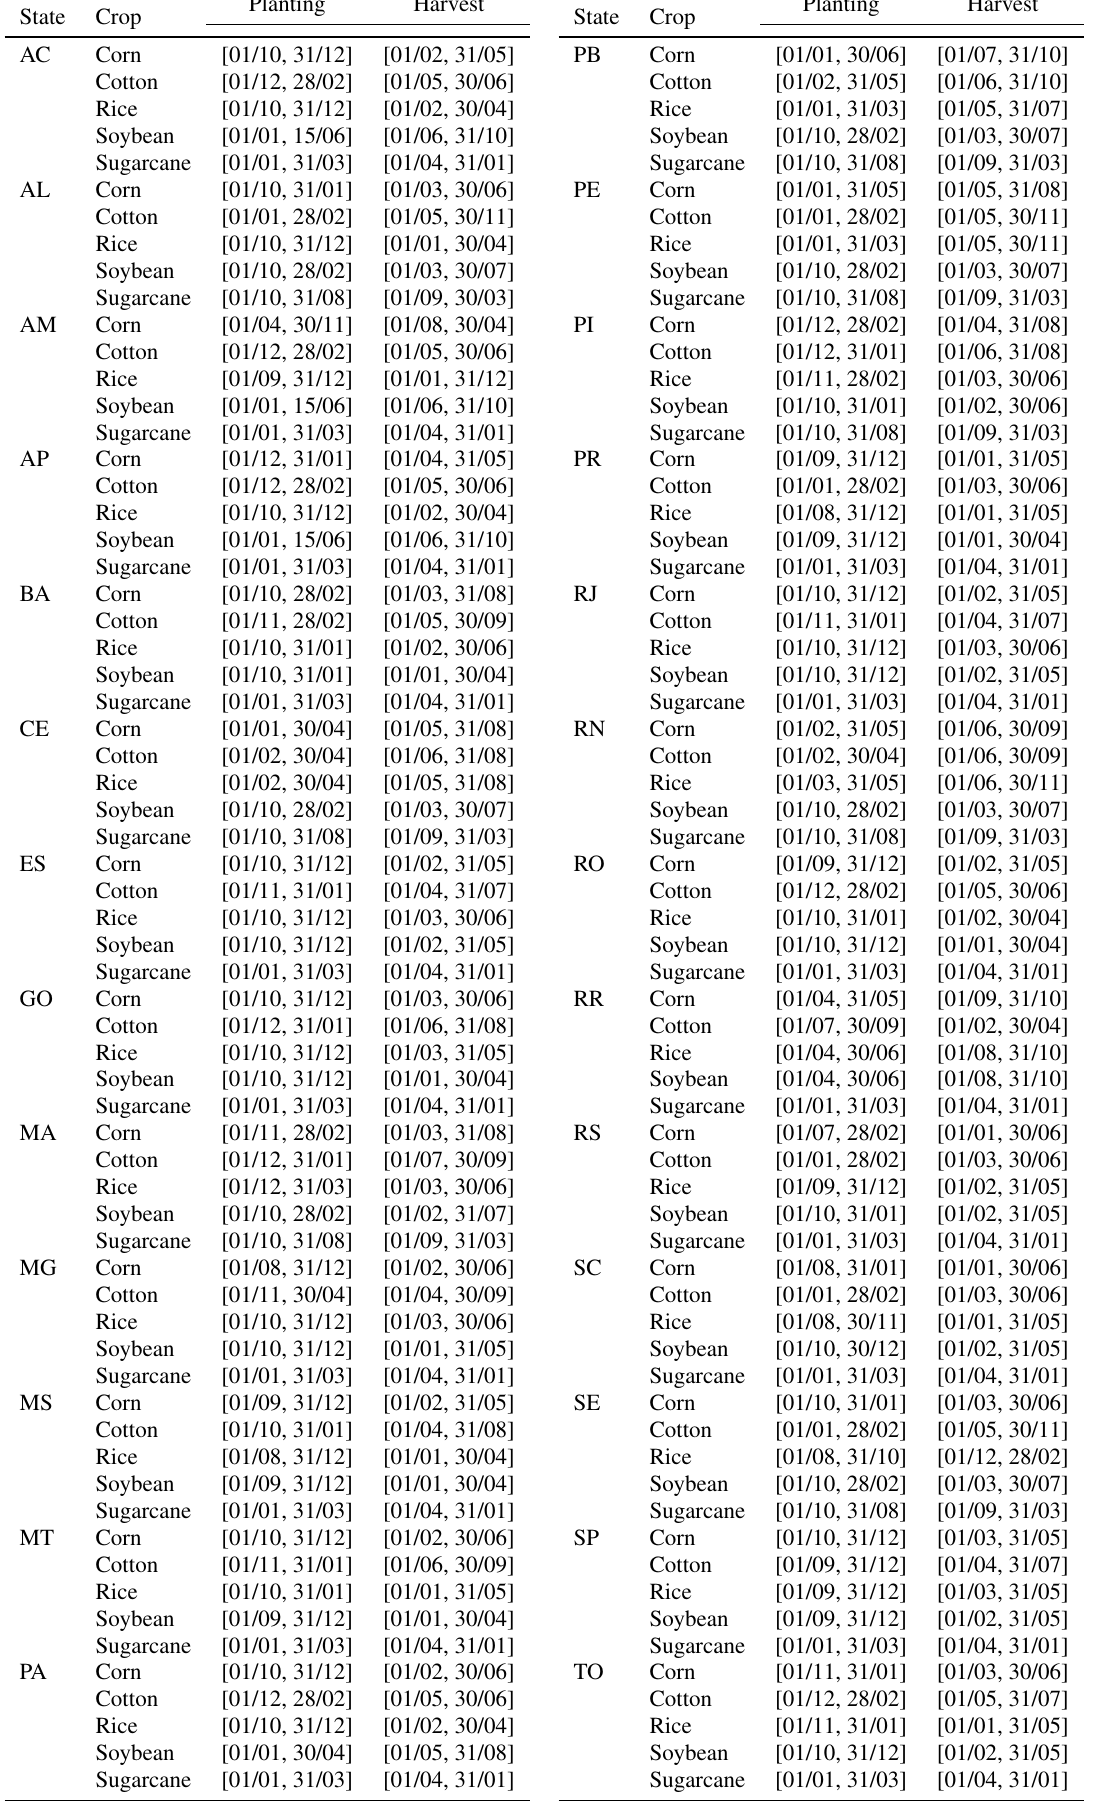
Table 6. Planting and harvesting dates for each state in Brazil according to the crop calendars used in this